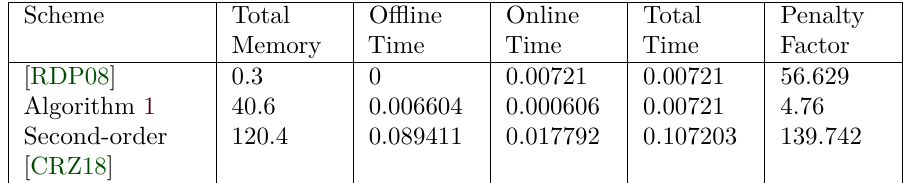
Table 8: Second-order instantiation of masked lookup table implementation of AES using [CRZ18], the RDP scheme and its variant with pre-processing (see Algorithm 1). Total RAM memory required for AES-128 is in KB and the execution times are in seconds.